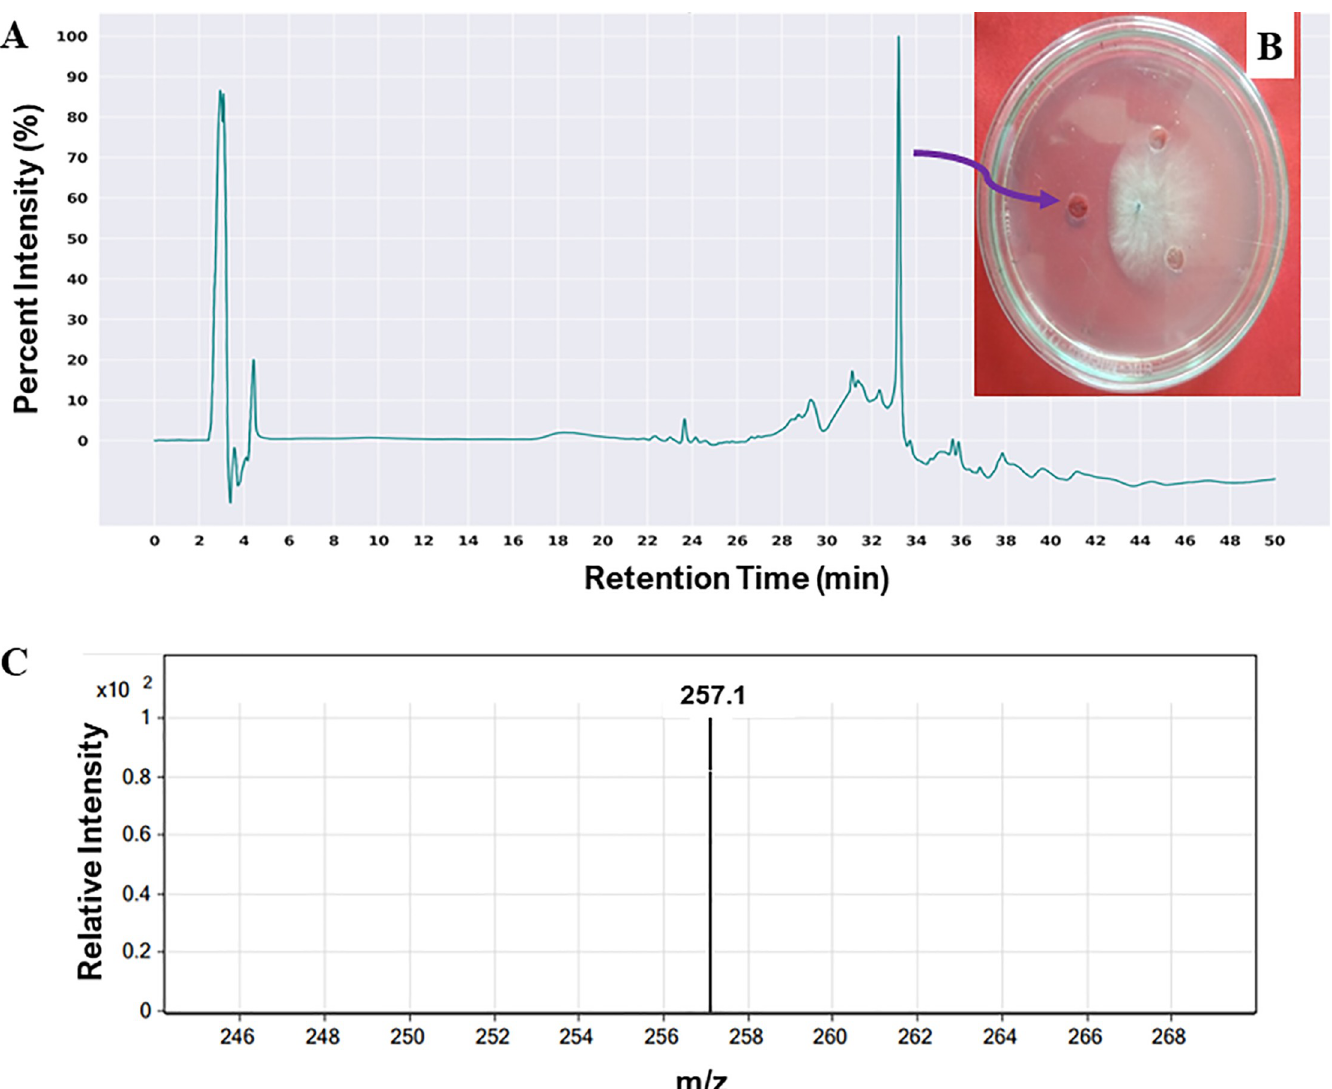
Fig 5. Identification of bioactive compounds in methanolic extract of B . contaminans NZ culture. (A) HPLC chromatograms of the active fraction (peak at 33.2 min retention time) upon reinjection. (B) Peak which inhibits the mycelial progression of M . phaseolina towards the active fraction when applied on the well, marked by a violet arrow. (C) LC-MS chromatogram of active peak identified to be pyrrolnitrin with a mass of 257.1 Da.